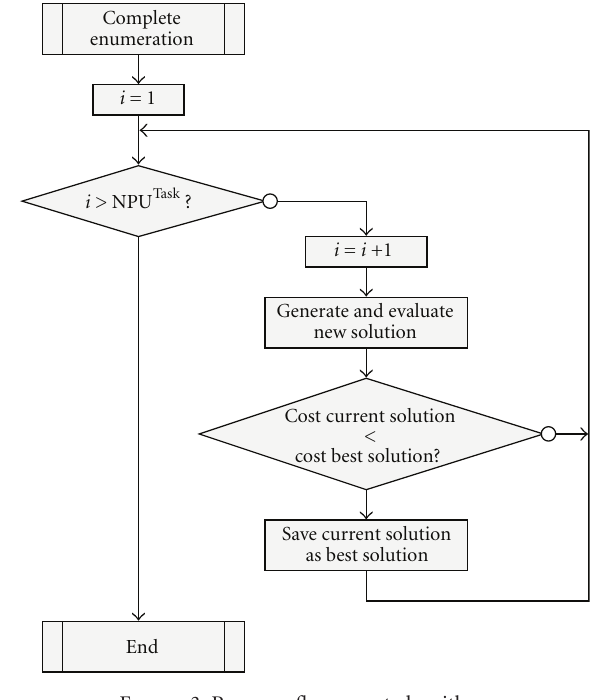
Figure 3: Program flow: exact algorithm.